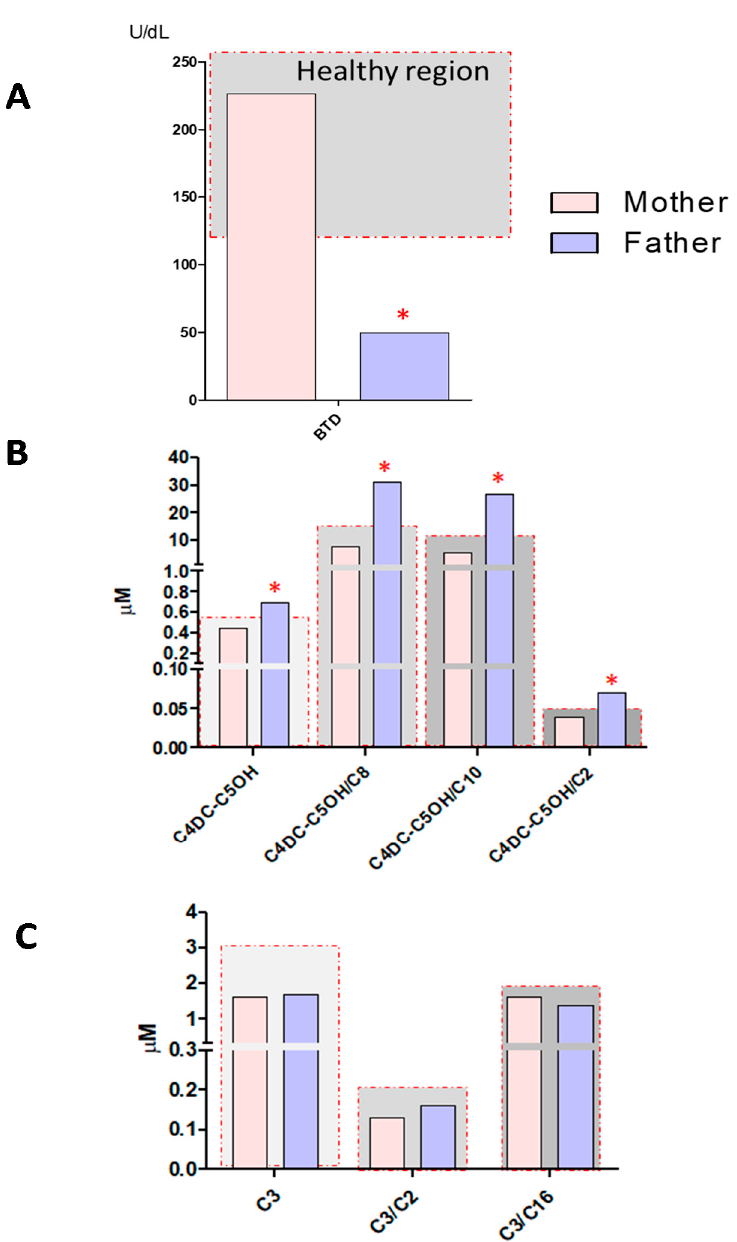
Figure 4. Panel A shows BTD activity measured in the DBS samples from the mother and father of the newborn. Panel B shows the levels of C4DC-C5OH and its ratios C4DC-C5OH/C2, C4DC-C5OH/C8, and C4DC-C5OH/C10 for DBS samples from the mother and father of the newborn. Panel C shows levels of C3 and its ratios C3/C2, C3/C16 in the DBS samples from the mother and father of the newborn. The samples inside the gray region are considered within the reference limits, while samples falling outside the gray region and marked with red asterisks are outside of the reference limits for newborn screening .